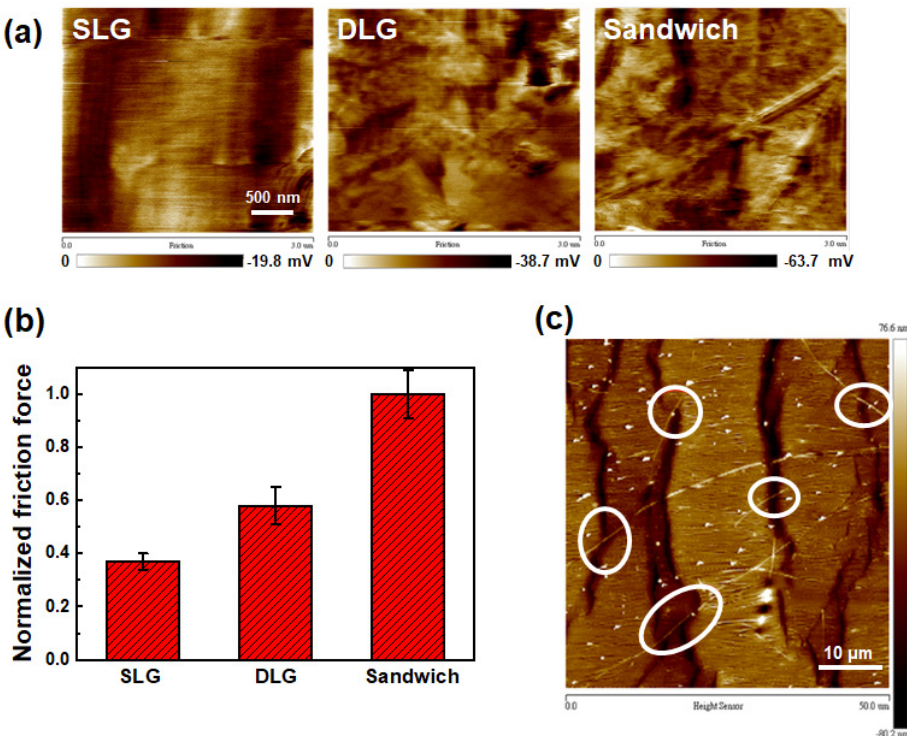
Figure 7. ( a ) LFM images and ( b ) normalized friction forces of the SLG, DLG, and sandwich structure; ( c ) AFM image of the sandwich structure under 30% strain.